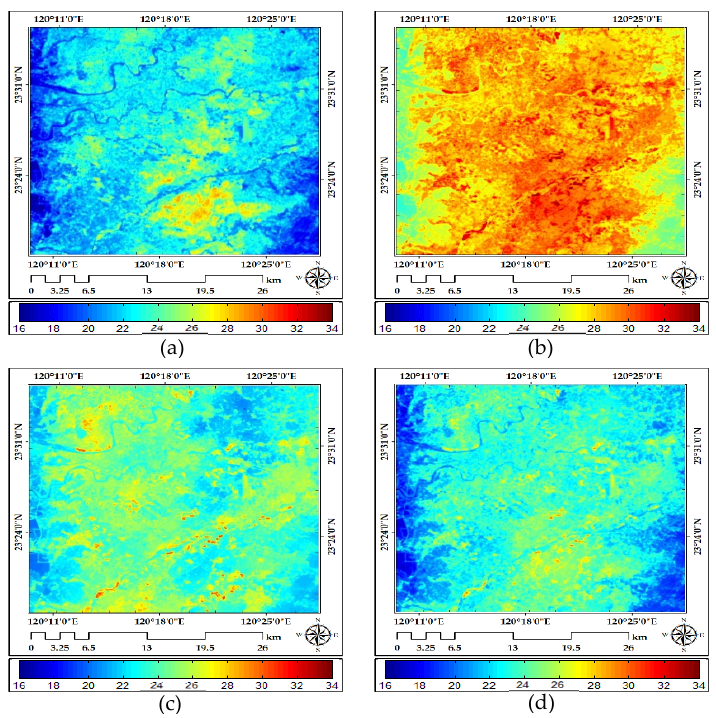
Figure 5. LST ( ◦ C) estimated from ( a ) Landsat TIR, ( b ) STARFM, ( c ) ESTARFM, and ( d ) STAEFM on 18 January 2019 .